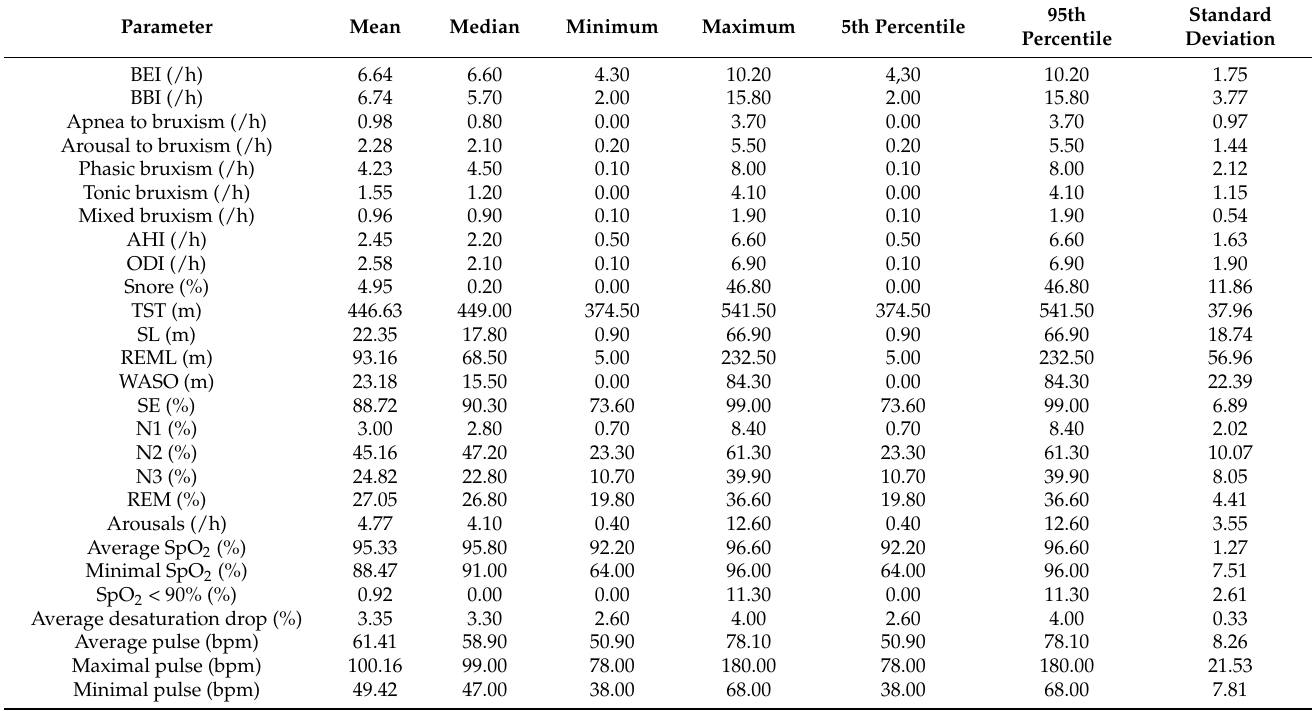
95th Standard Percentile Deviation